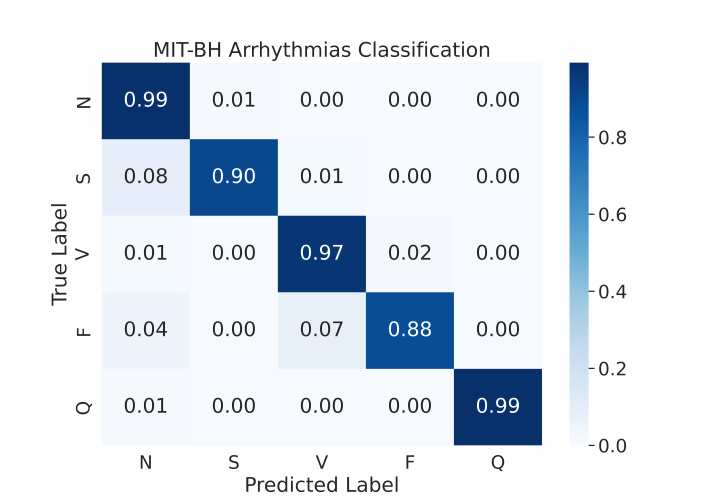
Figure 13. The confusion matrices for MIT-BH Arrhythmias classification.